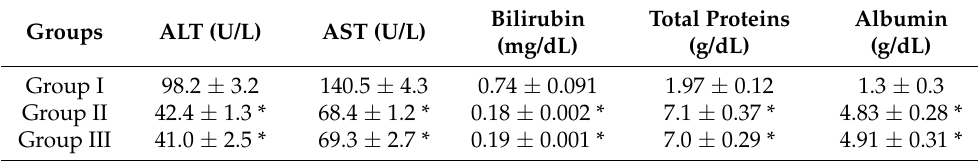
Table 3. Liver function tests in the experimental groups.